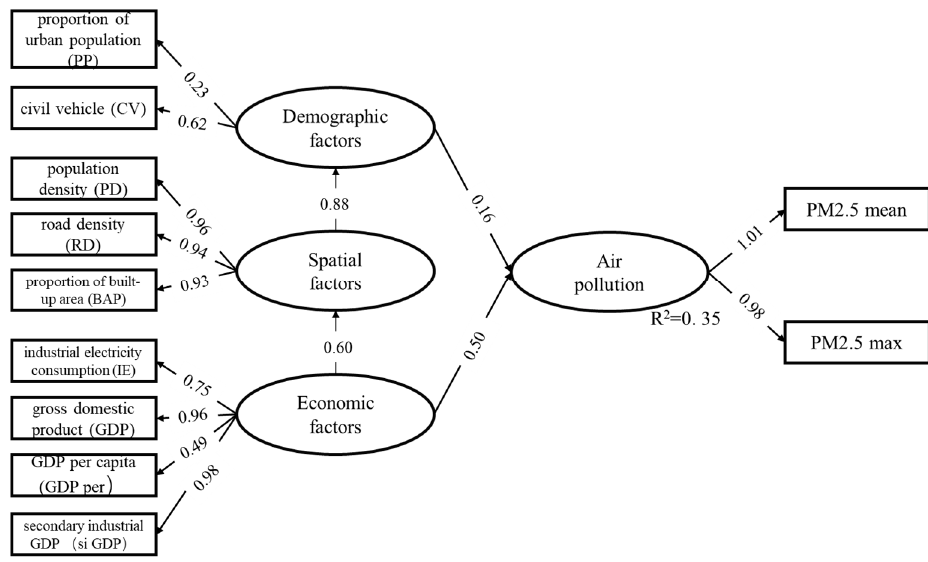
Figure 6. Results of the fitted model. The numbers in the figure on the paths represent the degree of contribution between variables.